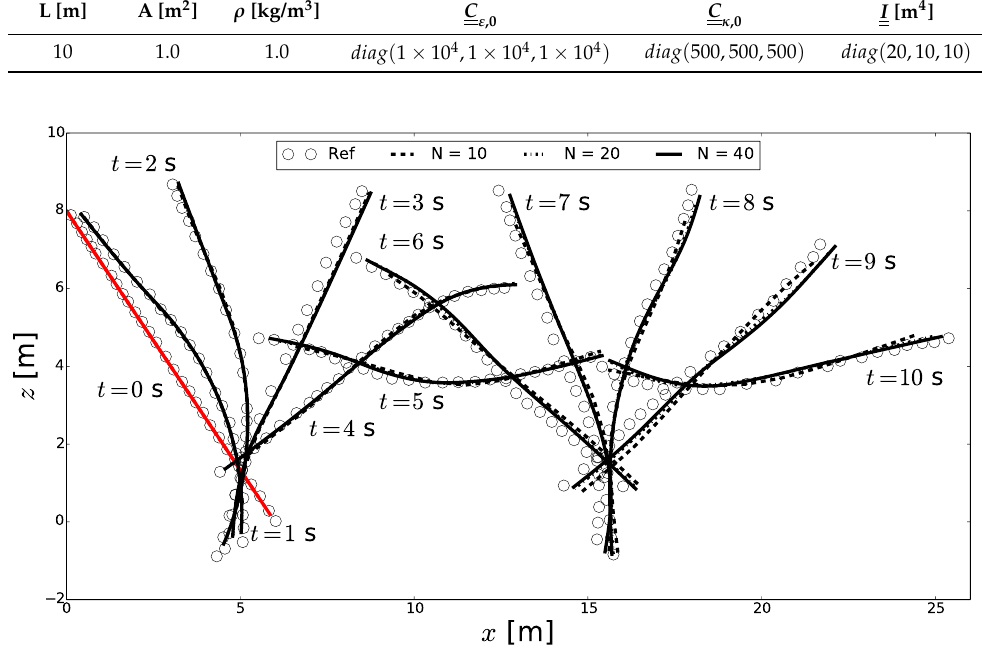
Figure 6. Motion of the free-free flexible rod for the two-dimensional load case. The red line shows the initial position of the rod. The reference solution was taken from